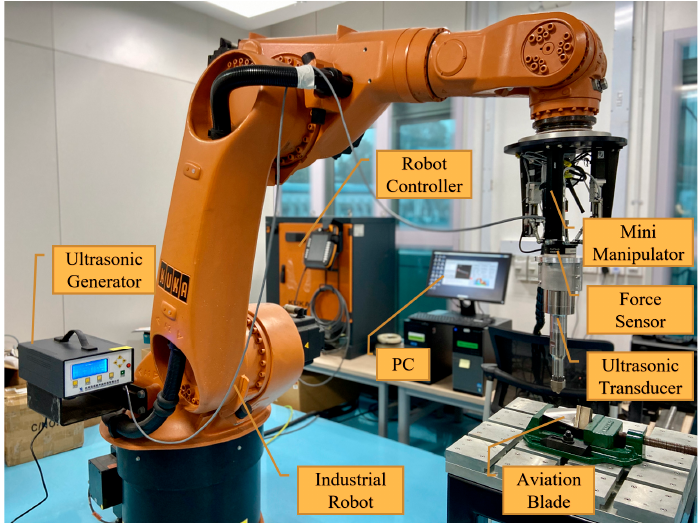
Figure 13. Experimental platform of robotic ultrasonic strengthening.